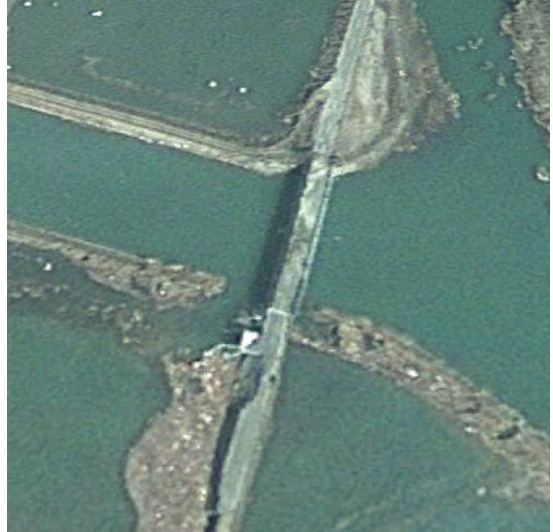
Figure 9. The ground scene of Fujisonetaishi Bridges in the Google Earth image acquired on March 14, 2011 (three days after the Tohoku